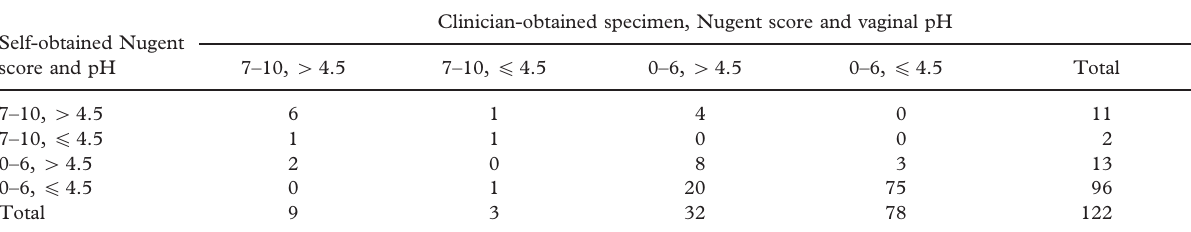
Table III. *Comparison of both Gram-stained vaginal fluid and vaginal pH collected by the two techniques. Self-obtained Nugent